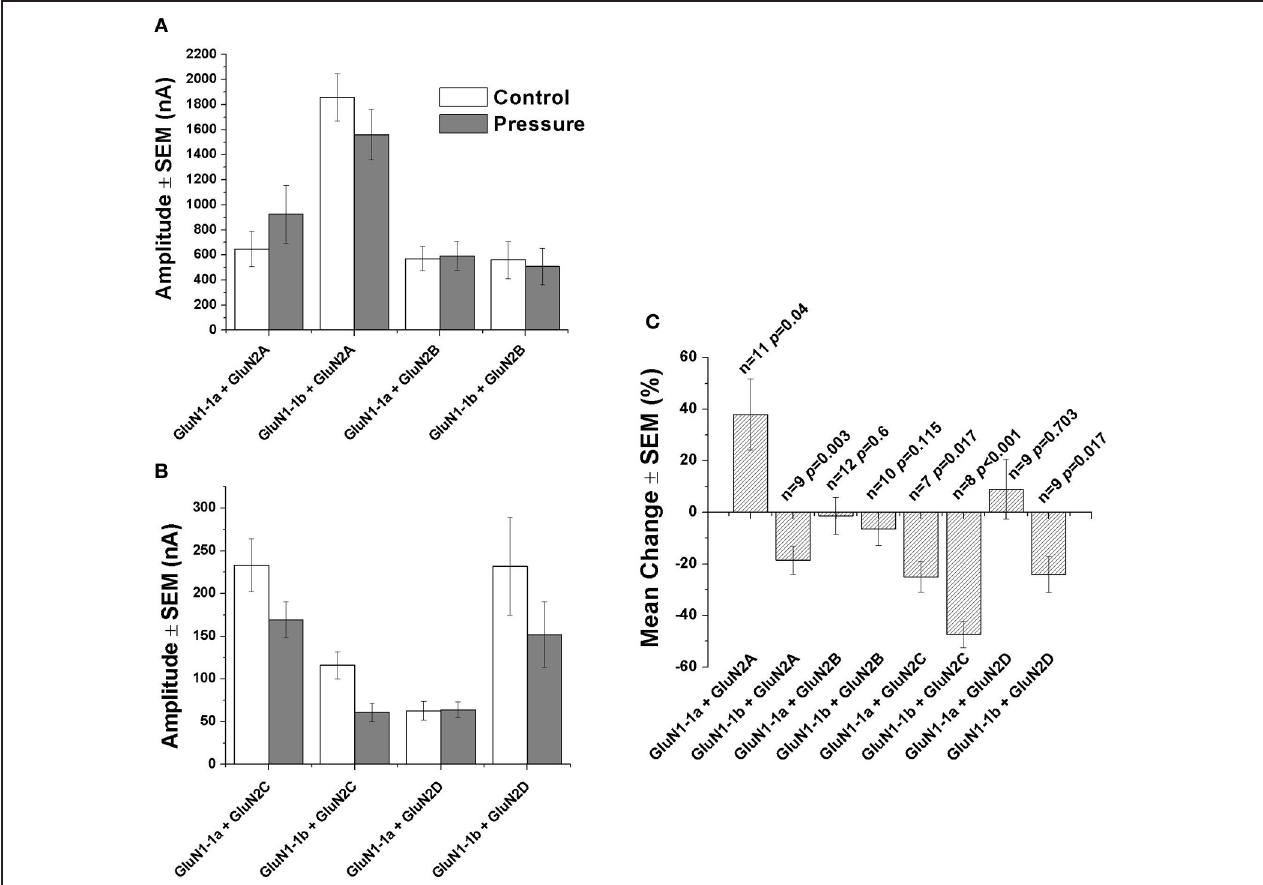
FIGURE 4 | Statistical analysis of NMDAR currents. (A) Mean current amplitude under control and hyperbaric conditions (GluN1-1a or GluN1-1b with GluN2A or GluN2B). (B) Mean current amplitude under control and hyperbaric conditions (GluN1-1a or GluN1-1b with GluN2C or GluN2D).